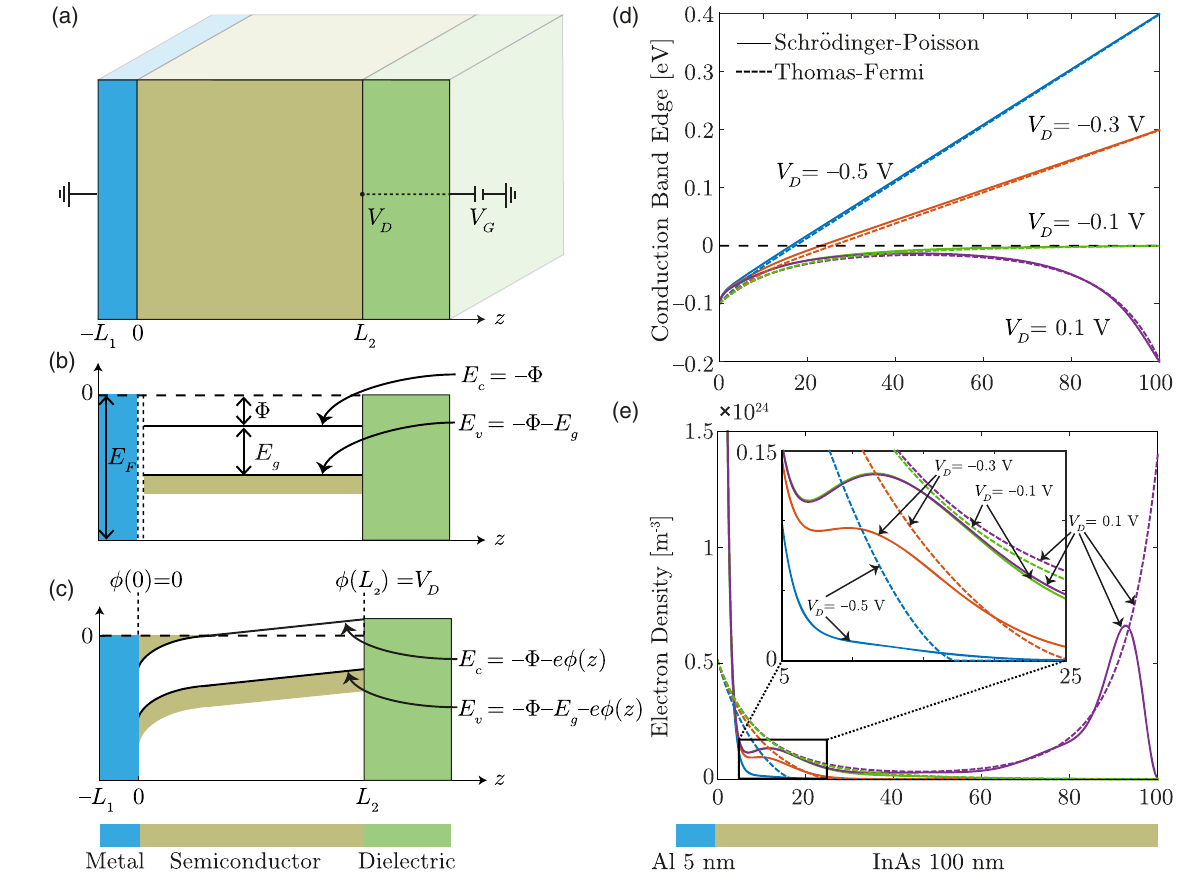
FIG. 1. (a) Schematic of the hybrid device consisting of a layer of metal, semiconductor, and dielectric with translational invariance in the plane. The rightmost edge of the dielectric is in contact with a gate electrode which keeps it at a voltage V grounded metallic layer. This translates into a voltage difference between the grounded metallic layer and the lower edge of the semiconductor, which we denote V . (b) Band diagram for the metal and semiconductor region before contact. (c) Band D diagram of the metal and semiconductor region after contact. (d) Self-consistent band edge profiles in the semiconductor region for several values of V . Solid lines indicate the results obtained via the self-consistent Schrödinger-Poisson method and dashed lines D indicate the results obtained from the Thomas-Fermi approximation. (e) Self-consistent charge density profiles in the semiconductor region for several values of V . Solid lines indicate the results obtained via the self-consistent Schrödinger-Poisson method and dashed D lines indicate the results obtained from the Thomas-Fermi